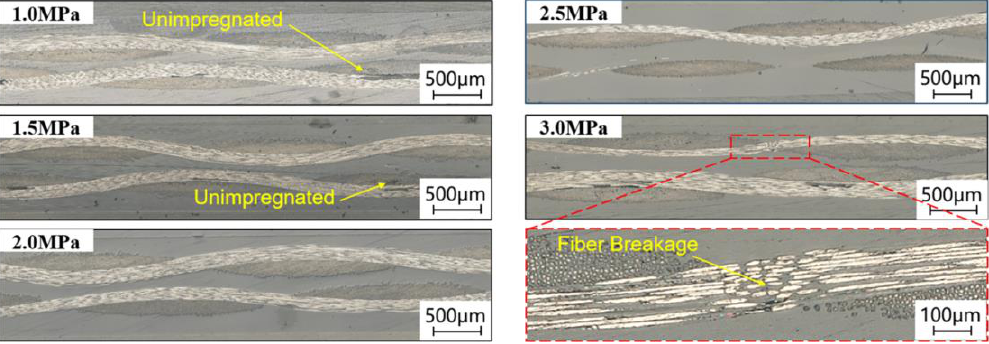
Figure 2. Micrographs of cross-section morphologies of CF/PA 6 composite laminates formed under different pressures. Table 1. Summary of the process parameters used for the manufacturing of CF/PA 6 composite laminate.